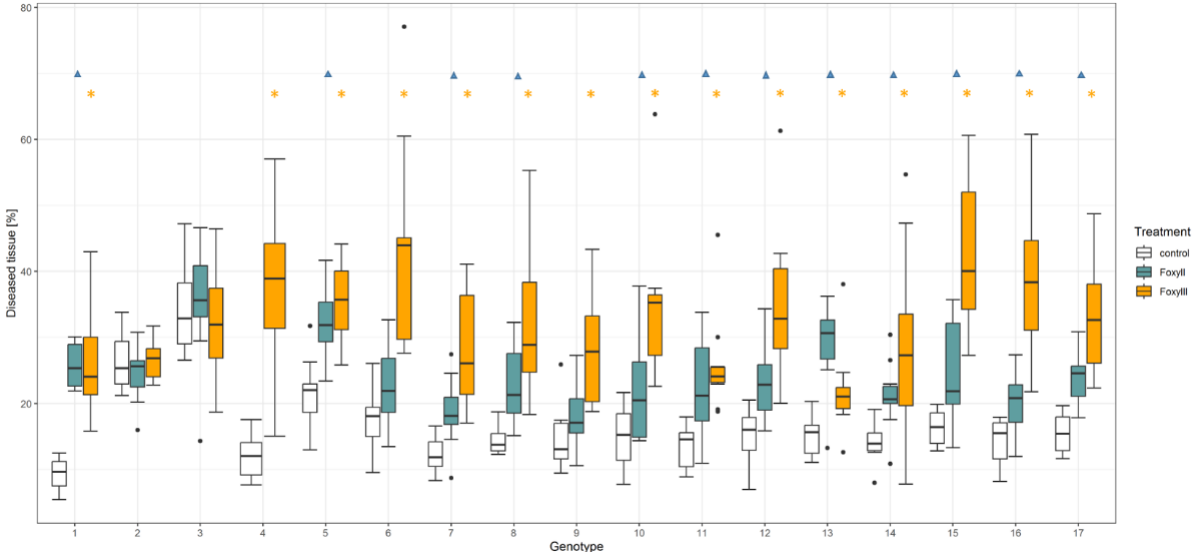
Figure 4. Resistance test against Fusarium oxysporum isolates Foxy II and Foxy III, 14 dpi. Percentage of diseased tissue for the 17 asparagus genotypes (Table 1) shown is the complete screening. * Indicates significance between the control and Foxy III for each genotype ( p < 0.05). ∆ Indicates significance between control and Foxy II for each genotype ( p < 0.05).